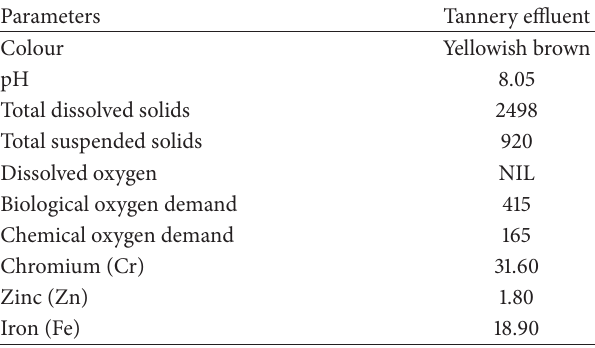
Table 1: Physicochemical characteristics of tannery effluent.